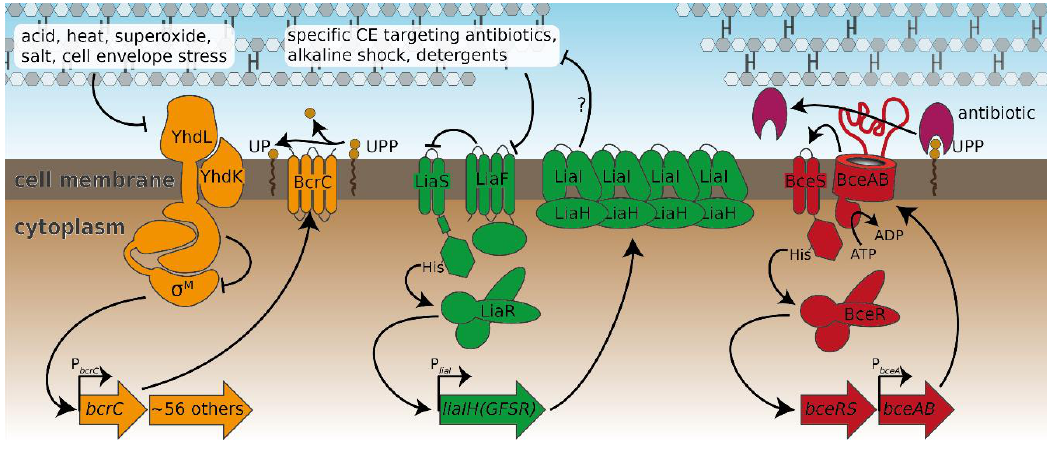
Figure 3. The three major cell envelope stress response modules of B. subtilis analysed in this study. The σ M module (left) is kept inactive under non-inducing conditions by its anti- σ factors YhdL / YhdK [10]. Upon exposure to, e.g., acids or cell envelope stress, σ M is released and free to guide RNA polymerase to its target promoters such as P bcrC [11]. The Lia module (middle) senses a plethora of external stresses through a yet-undetermined sensing mechanism. Upon stress sensing, the inhibition of the two-component system LiaS / LiaR by LiaF ceases [12], which subsequently allows increased expression of the genes involved in the signaling cascade as well as liaI and liaH . The Bce module (right) is shown as a representative of all bce-like modules of B. subtilis . Here, the ABC-transporter BceAB is thought to remove the antibiotic bacitracin from its target, UPP [18]. BceAB activity stimulates the two-component system BceS / BceR and thereby leads to the increased production of BceAB [19,20]. Regulation patterns are depicted with arrows; arrowheads and T-heads indicate activation and inhibition,